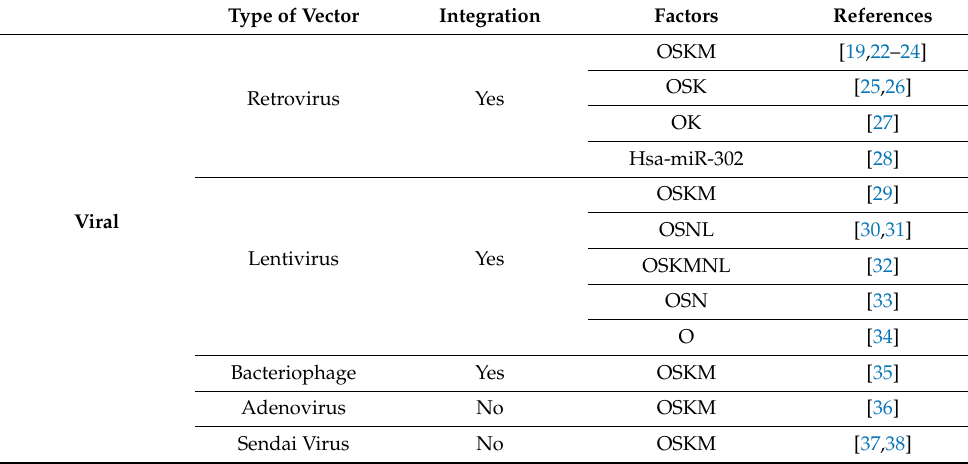
Table 1. Reprogramming methods used in human somatic